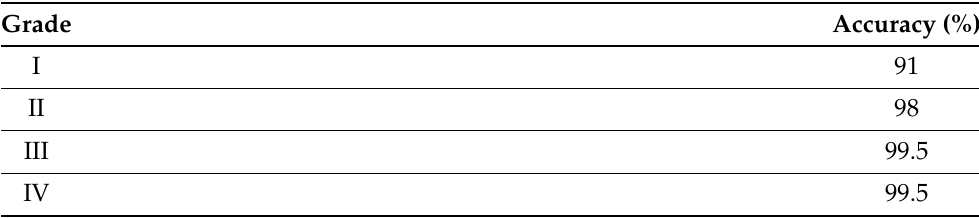
Table 10. Accuracy on different gradings of knee Osteoarthritis (Grade I, II, III,